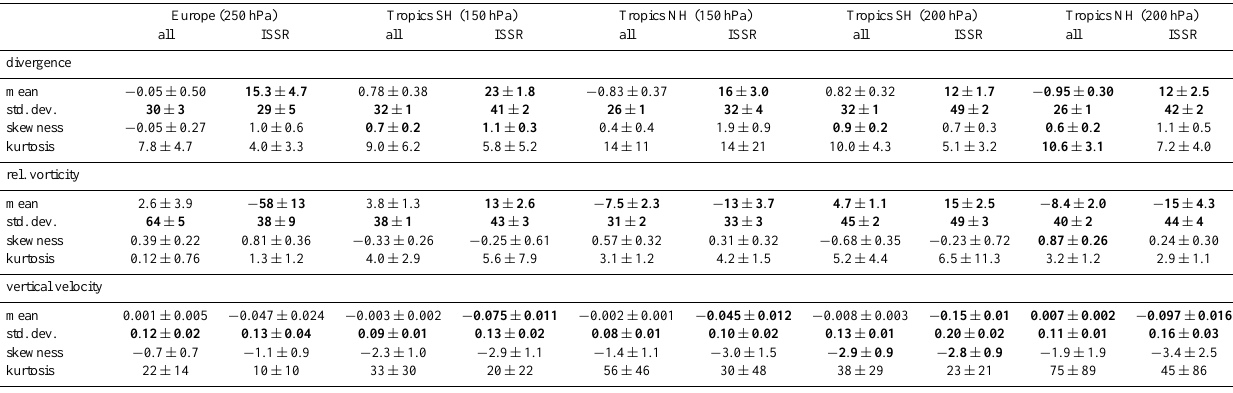
Table 1. Statistical parameters mean, standard deviation, skewness and kurtosis, of dynamical fields within ISSRs and generally in three geographic regions on appropriate pressure levels. Mean values and standard deviations of divergence and vorticity (units m 2 s − 2 ) have been scaled by 10 6 , while skewness and kurtosis are dimensionless. For the meaning of the parameters and their standard deviations see the text. Values that are at least three times larger than their standard deviation are printed in